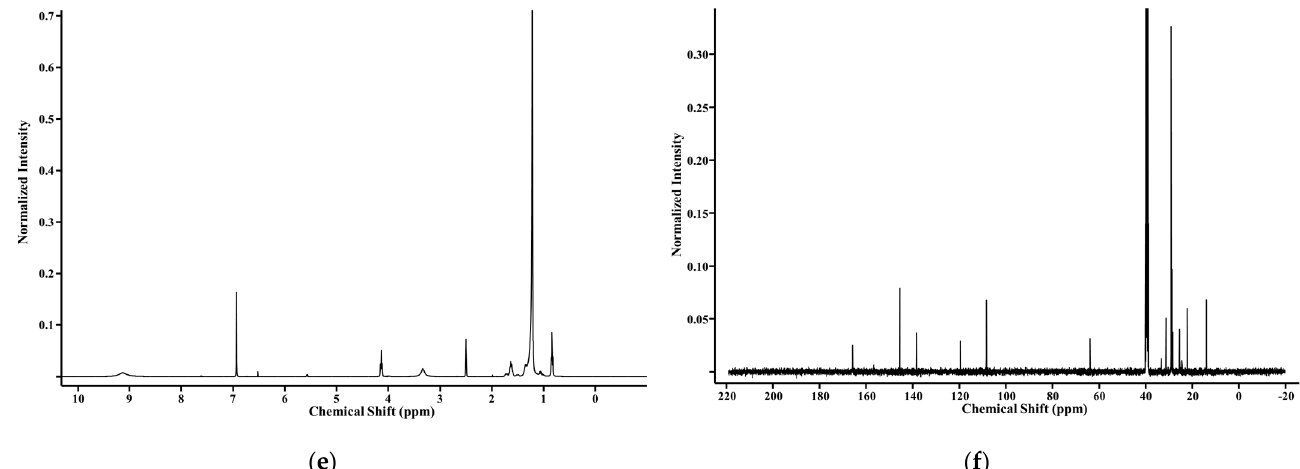
Figure 2. NMR spectrum of GP, GPa, and GE: ( a ) 1 H-NMR spectrum of GP; ( b ) 13 C-NMR spectrum of GP; ( c ) 1 H-NMR spectrum of GPa; ( d ) 13 C-NMR spectrum of GPa; ( e ) 1 H-NMR spectrum of GE; ( f ) 13 C-NMR spectrum of GE.